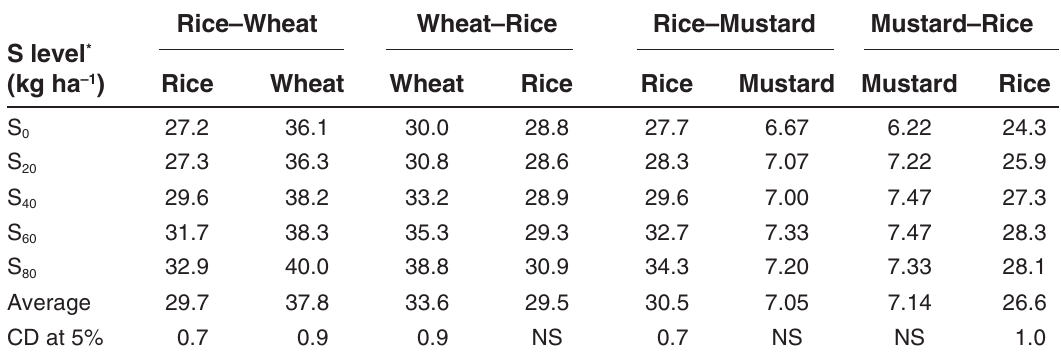
Mean Yield of Rice, Wheat, and Mustard Grown in Different Sequences (q ha –1 ) Rice–Wheat